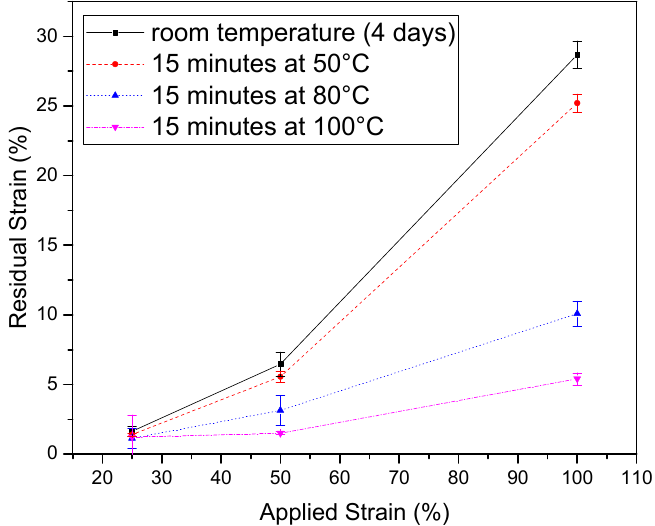
Figure 4. Residual contraction behavior in Zn-EMAA/Fe 3 O 4 composites as a function of the applied static prestrain and four annealing conditions.